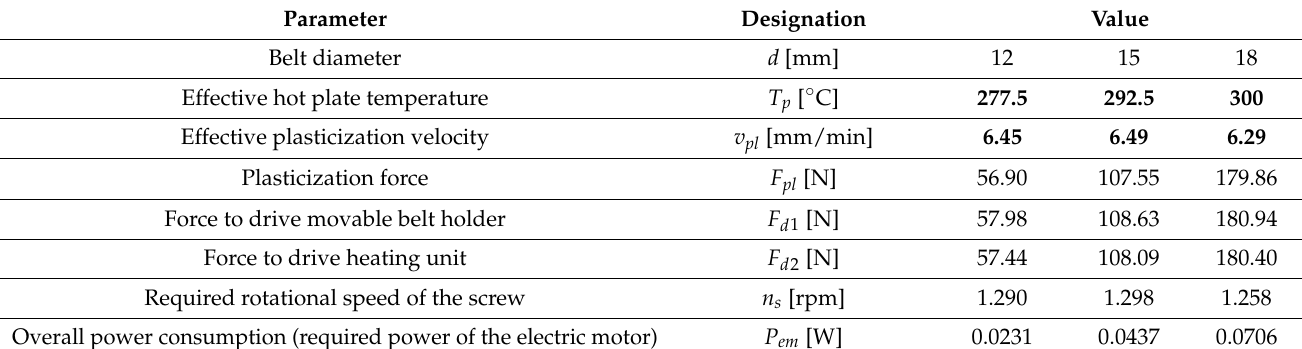
Table 5. The results of the power consumption